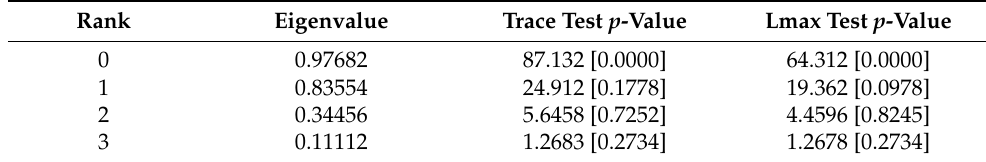
Table 5. Johansen procedure test results for P t , D t , S t and R t .